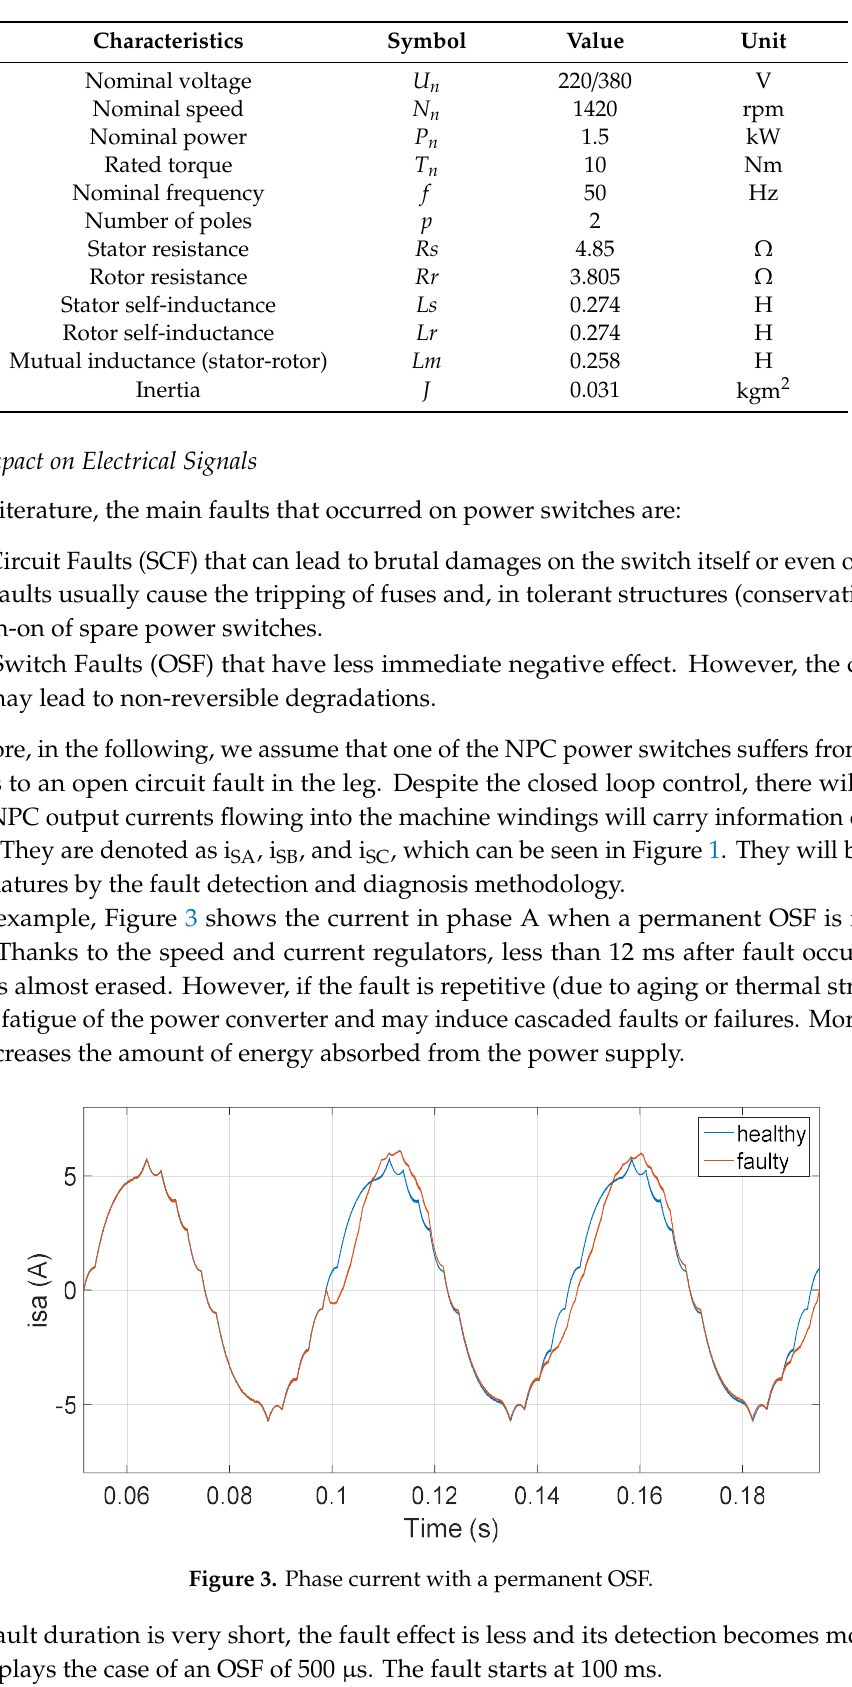
Table 1. Induction machine main characteristics.